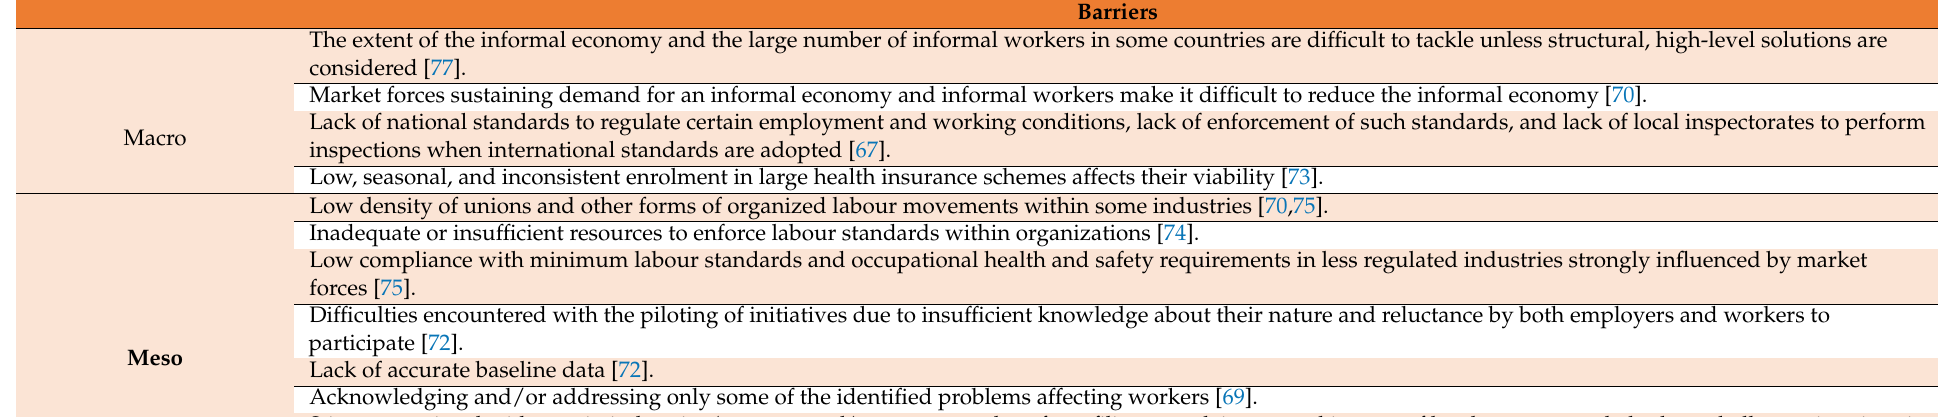
Table 5. Common macro- and meso-level barriers and facilitators to the successful implementation of initiatives.